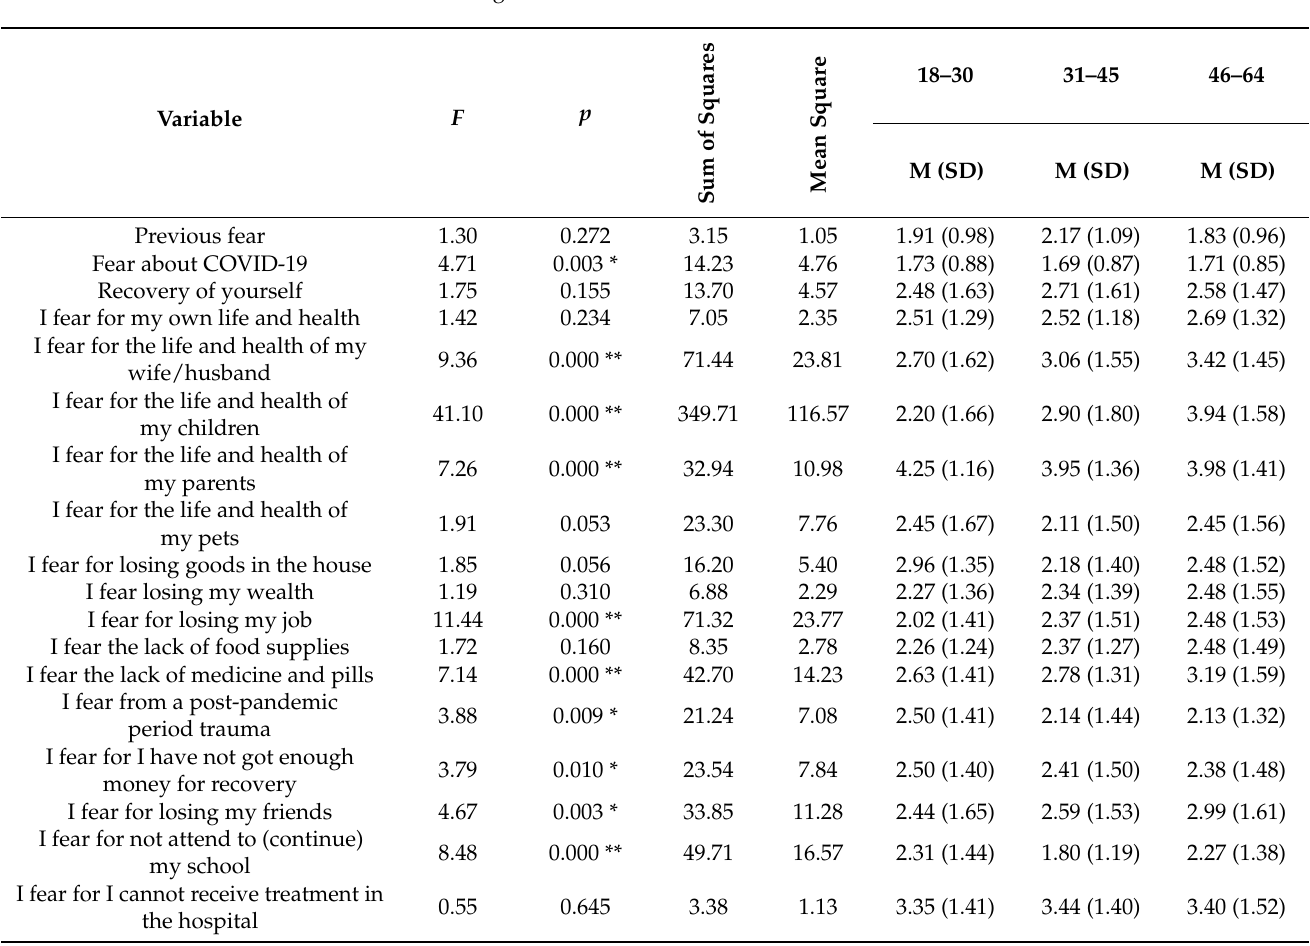
Table 5. One-way ANOVA results of the relations between the variables about fear caused by COVID-19 and age.